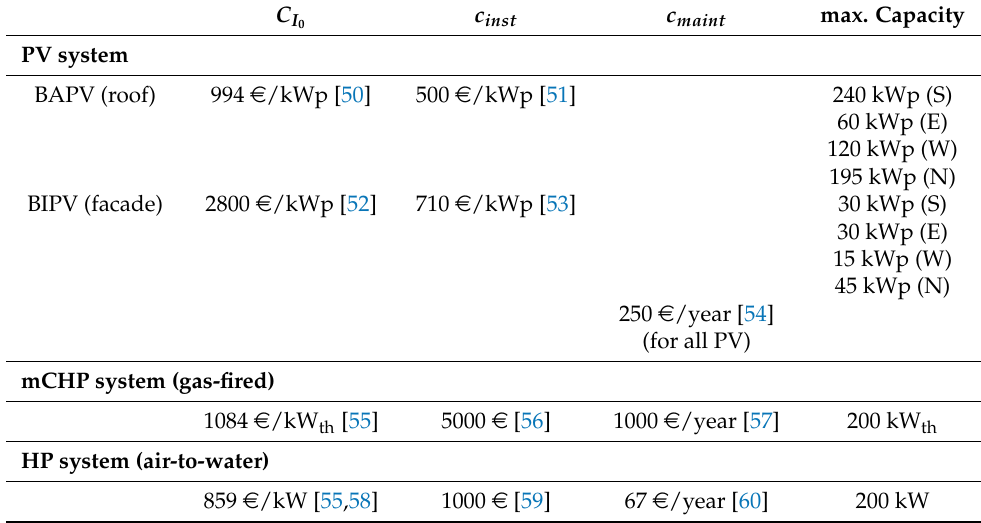
Table 4. Costs and maximum capacities for new energy system